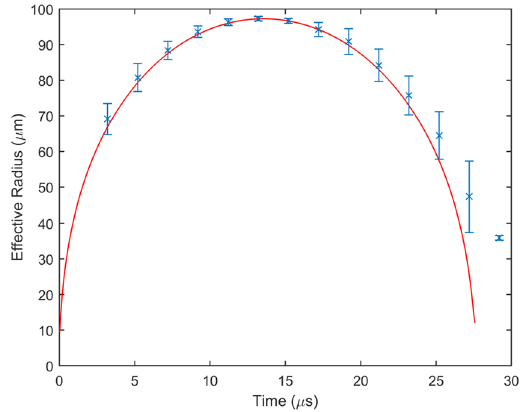
Figure 4. Evolution of the effective bubble radius with time. Blue ‘x’ marks shows average bubble radius with error bars depicting the standard deviation in observation. The expected dynamics from an inertially controlled spherical bubble, following Eq. (1), is shown in